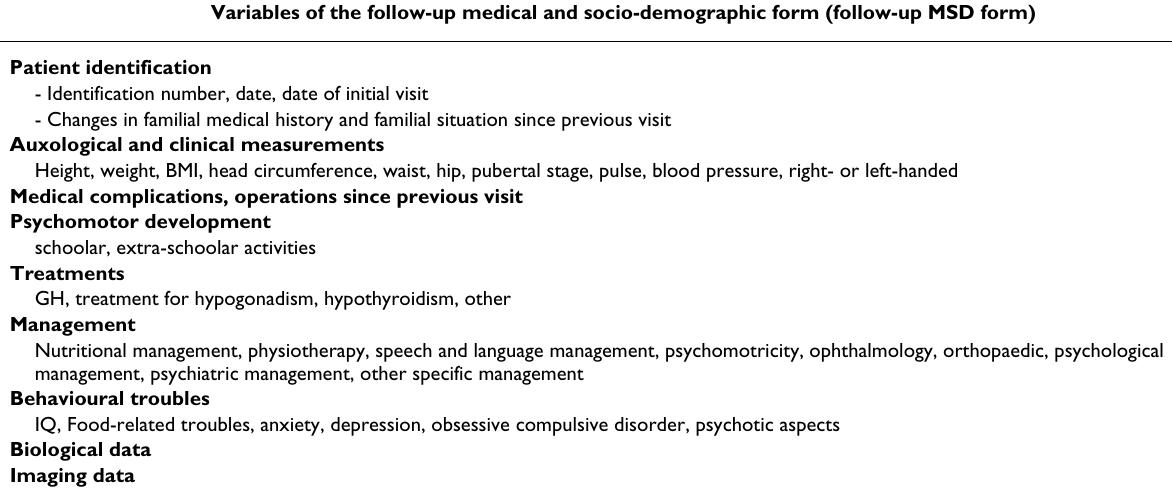
Table 2: List of variables of the follow-up medical and socio-demographic form (follow-up MSD form) Variables of the follow-up medical and socio-demographic form (follow-up MSD